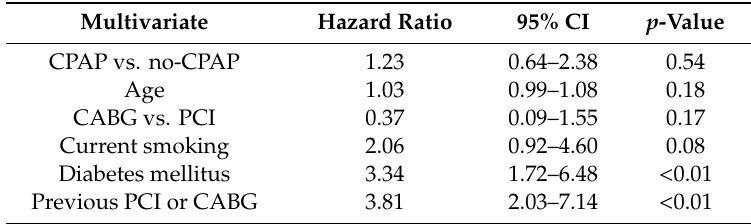
Table 2. Cox regression analysis of baseline covariables associated with risk for adverse cardiovascular outcomes in revascularized patients with ACS and non-sleepy OSA in the intention-to-treat analysis ( n = 171; 37 patients reached the composite endpoint).